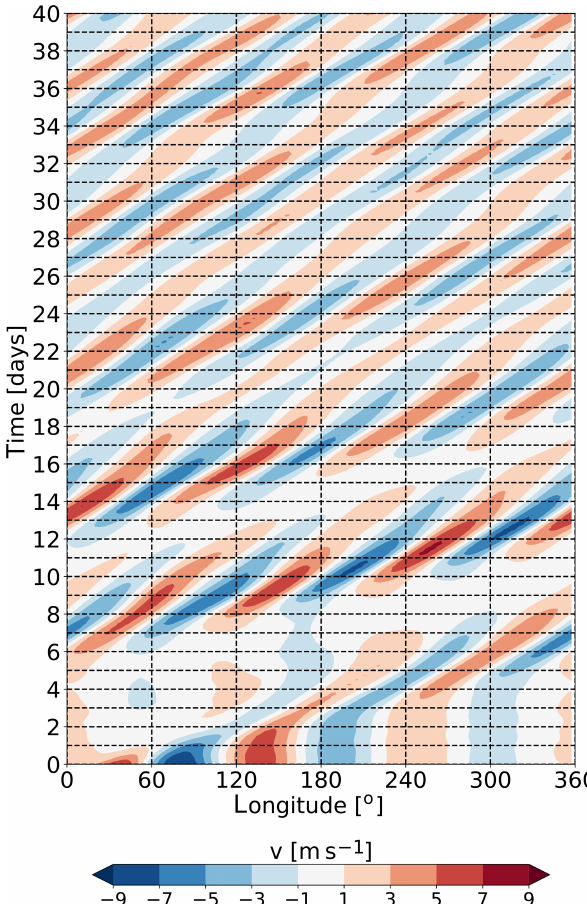
Figure 1. Development of a barotropically unstable initial state for a model setup with a strong narrow jet at 45 ◦ N. The plot shows a Hovmöller diagram of the meridional wind component of the tran- sient part of the flow, v (cid:48) = v − v , averaged over 30–60 ◦ N.